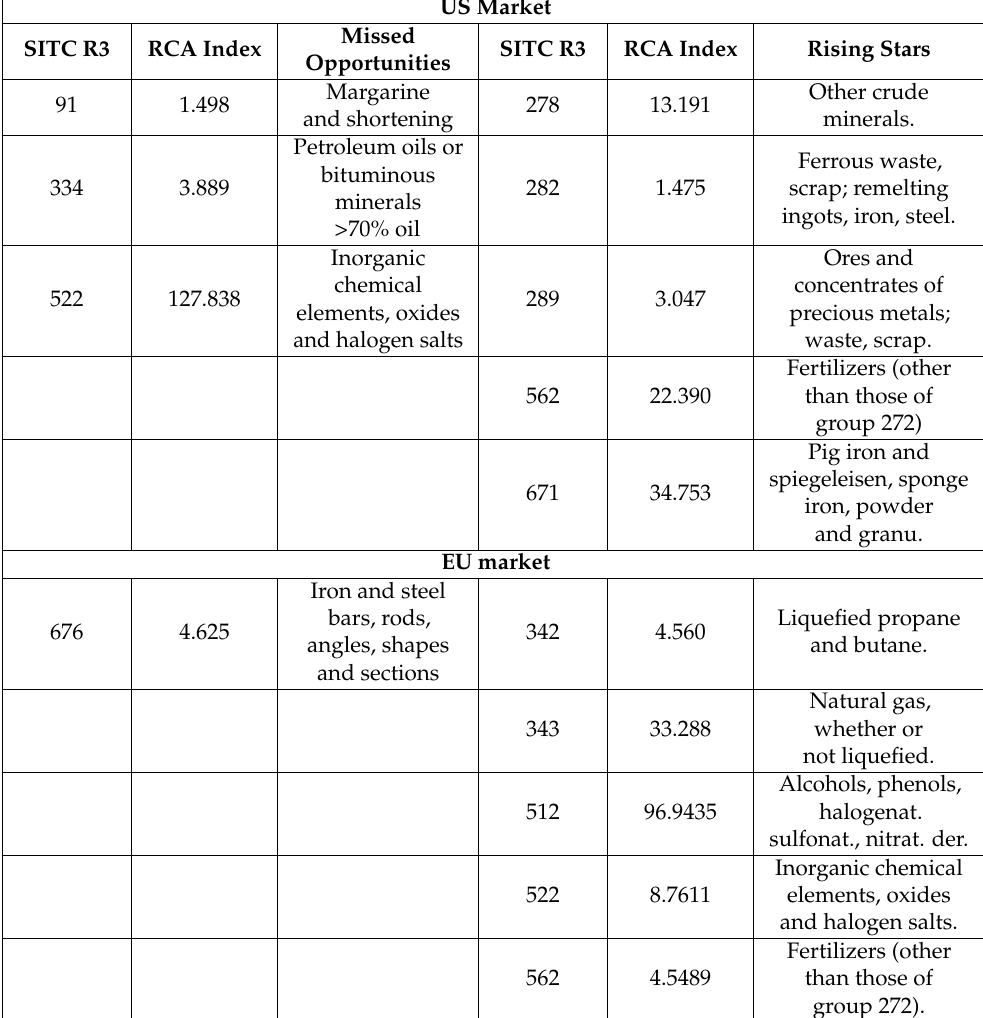
Table A6. Examples of feasible export areas for T&T’s main extra-regional